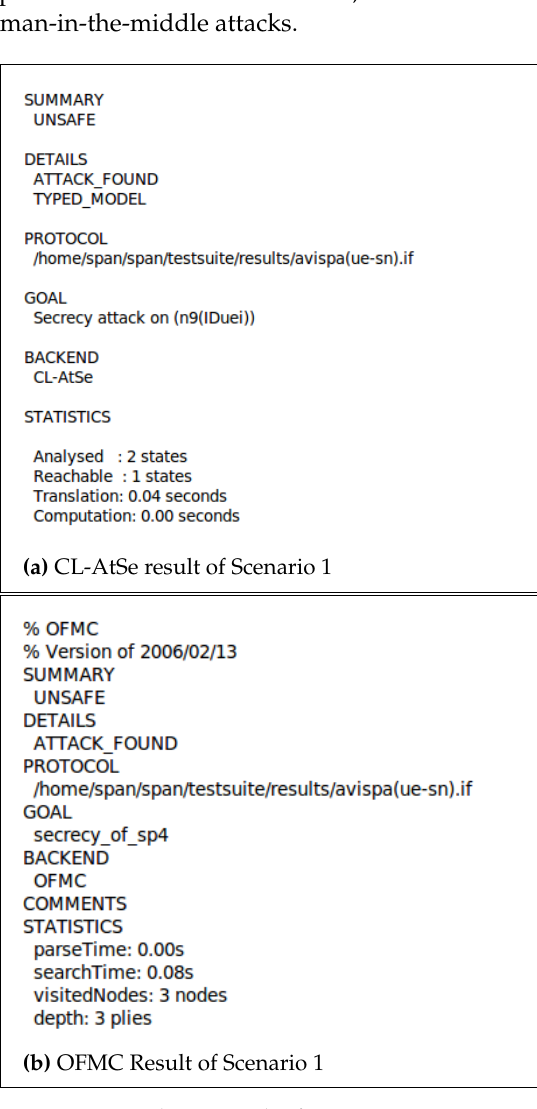
Figure 12. Simulation result of Scenario